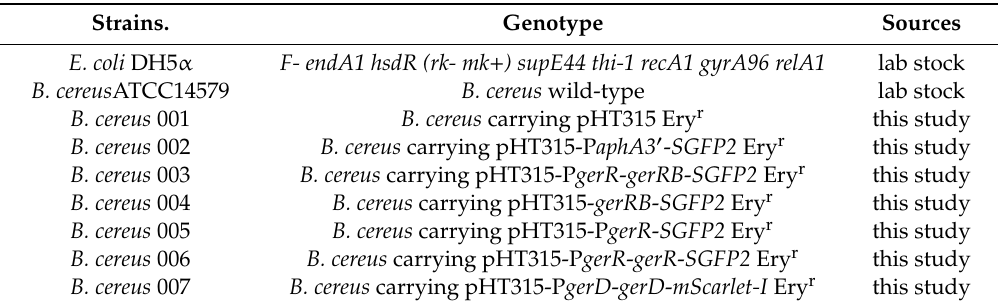
Table 1. Strains used in this